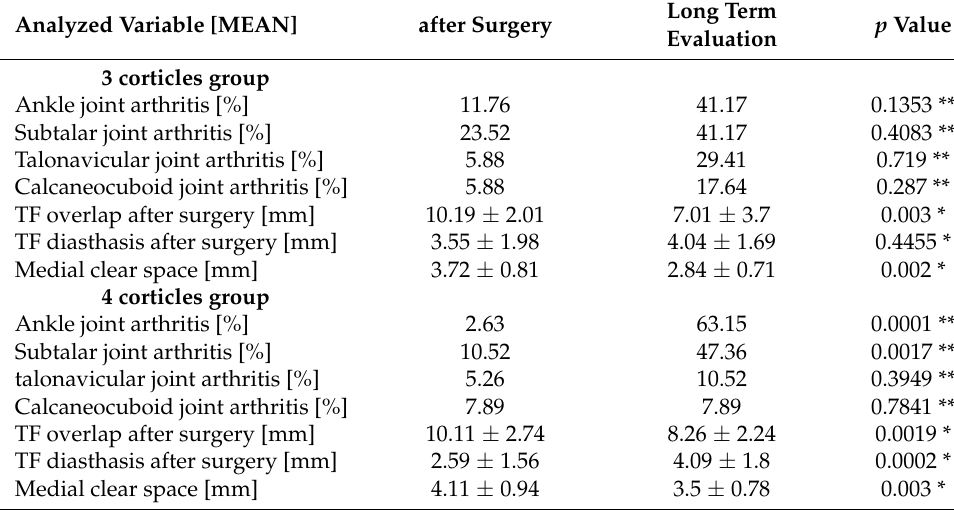
Table 3. Detailed radiological assessment of patients after surgery and in last control visit in the 3 corticles group and 4 corticles